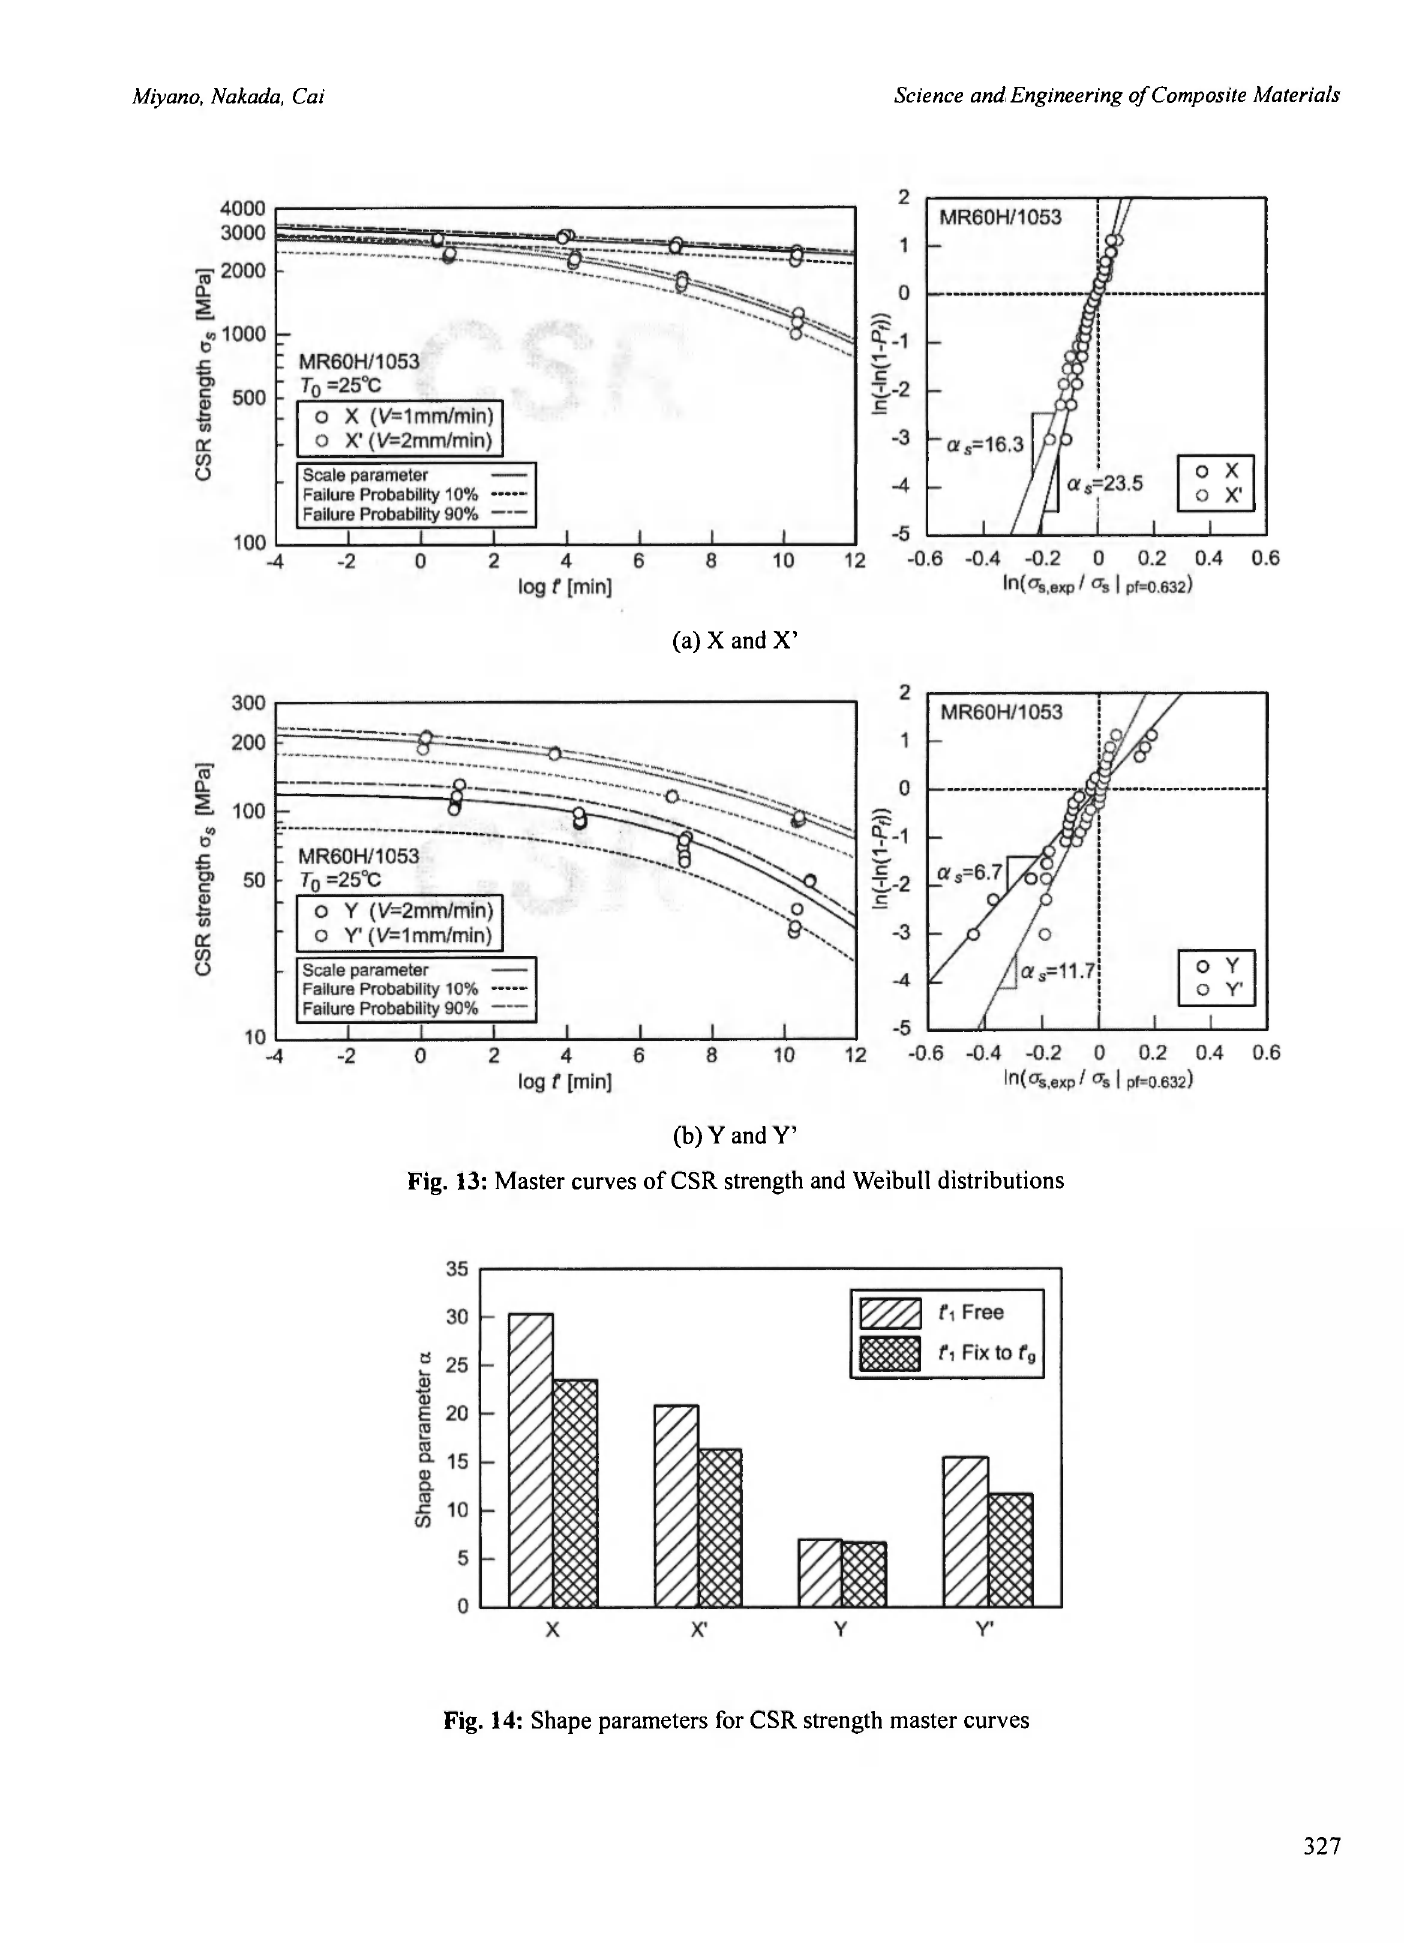
Fig. 13: Master curves of CSR strength and Weibull distributions